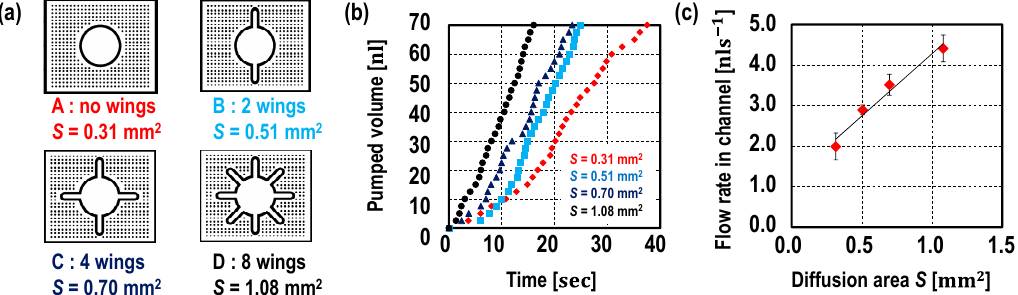
Figure 4. ( a ) Pump design, ( b ) measured pumped volume over the time, and ( c ) the flow rates against the diffusion areas. The diffusion areas were designed to be 0.31 mm 2 , 0.51 mm 2 , 0.70 mm 2 and, 1.08 mm 2 , where, the PDMS wall heights were fixed at 50 µm and the PDMS wall thickness was set at 100 µm. The pumped volume while liquid flow in microfluidic channel is measured corresponding to the liquid position is shown in graph ( b ). As shown in the graph ( c ), the flow rate is proportional to the diffusion area. All of the devices were tested at least three times. Please refer to the video clips.